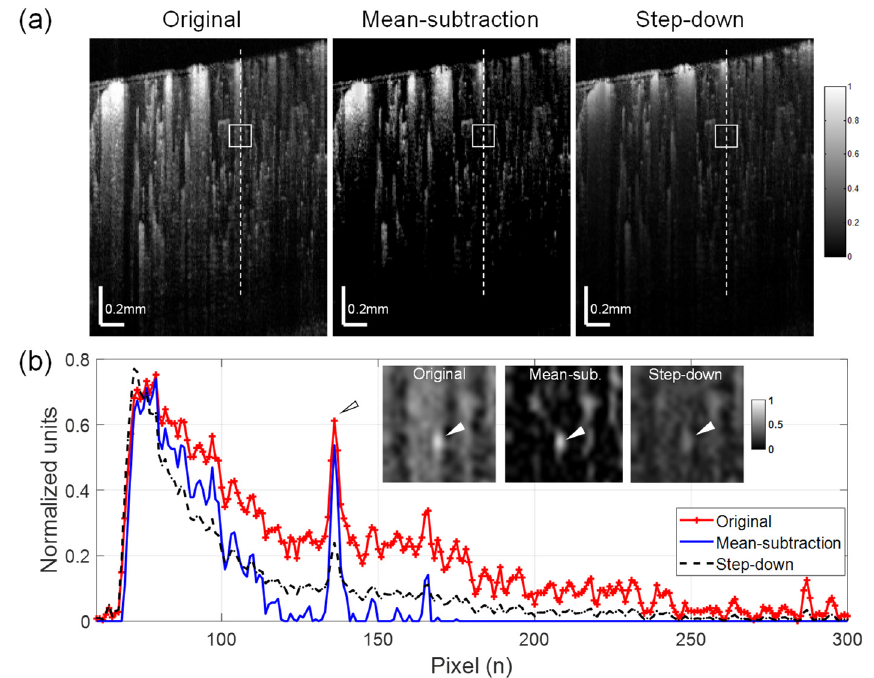
Figure 4. Comparisons of de-shadowing using the proposed mean-subtraction method and the well-established step-down exponential filtering method. ( a ) Normalized OCTA cross-sections of mouse cortex: original (left), processed with the mean-subtraction method (middle) and the step-down method (right). ( b ) Depth profiles taken along the dashed lines in ( a ) showing largely reduced shadow tails for both methods. However, the mean-subtraction method results in higher signal contrast for a small vessel (arrow head) in the de-shadowed region compared with the original image and the image processed with the step-down approach. Insets in the graph are enlargements of a region indicated as boxes in ( a ), where the underlying vessel (arrowhead) is brighter and more distinct with the proposed method.